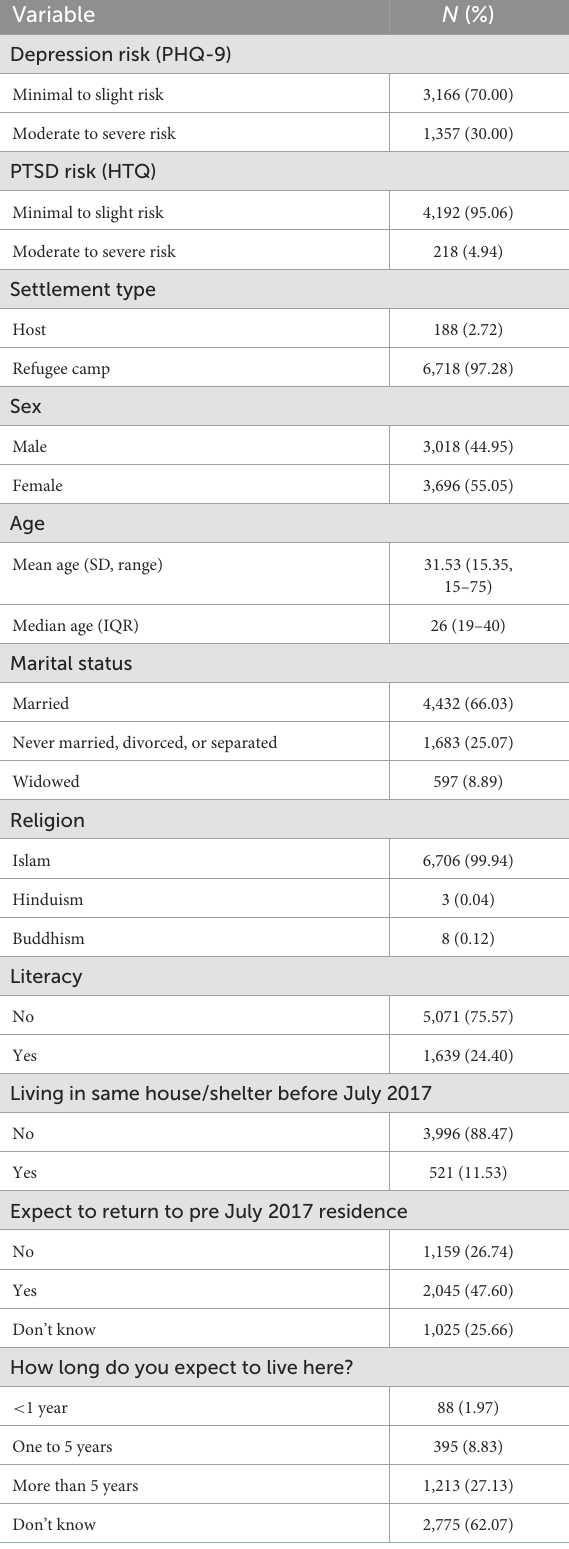
TABLE 1 Descriptive statistics of 6,906 Rohingya refugees living in Cox’s Bazar, Bangladesh as it relates to trauma exposure, daily stressors, and mental health